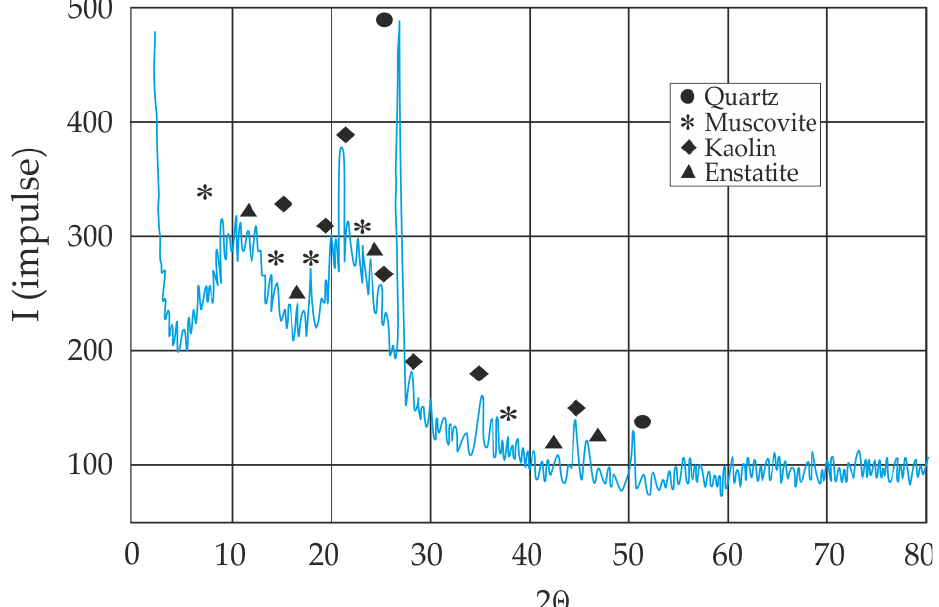
Figure 5. X-ray (X-ray di ff raction) di ff raction data for diatomite .